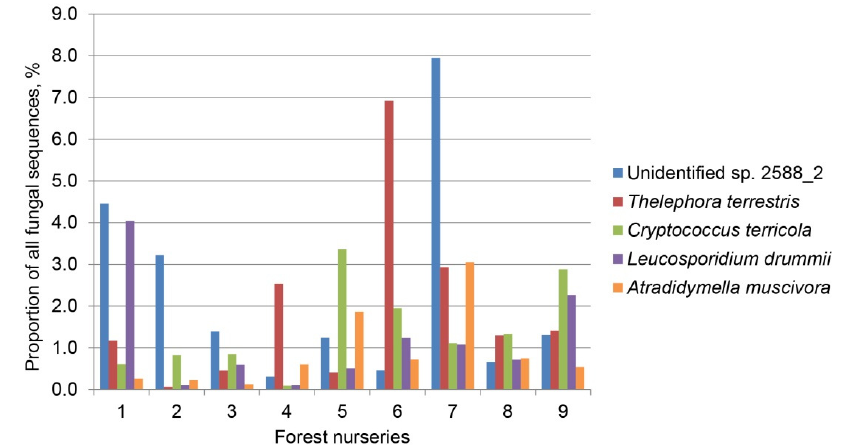
Figure 3. Relative abundance of the five most common fungal taxa (data is pooled within each